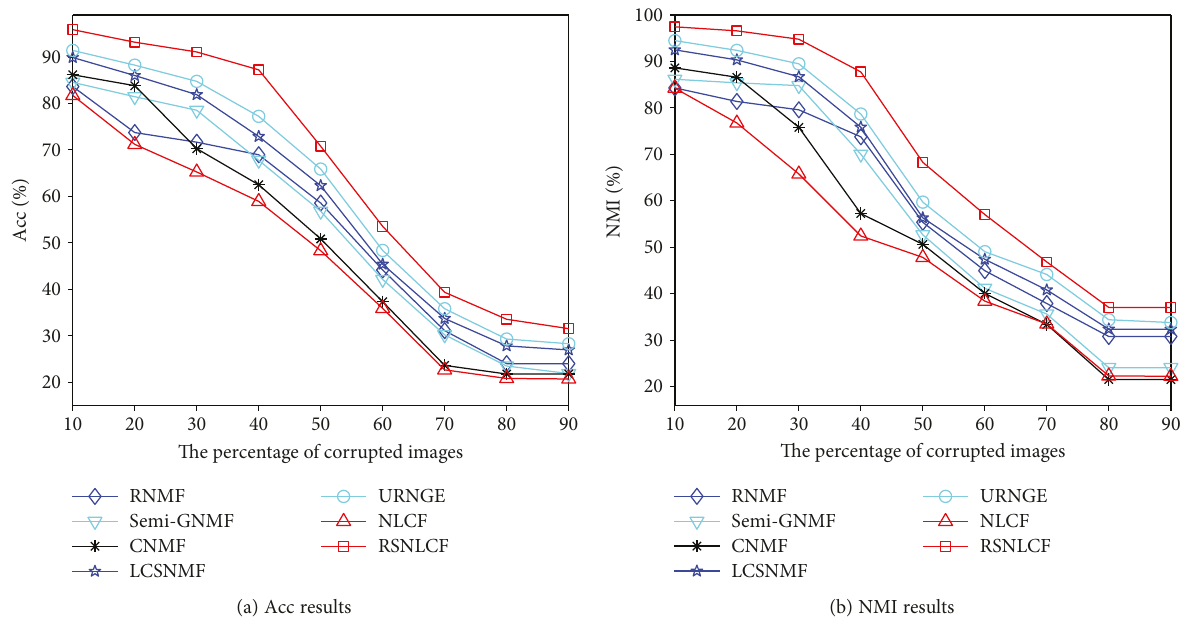
Figure 3: Clustering Acc and NMI curves across percentages of corrupted images for the compared methods on the ORL